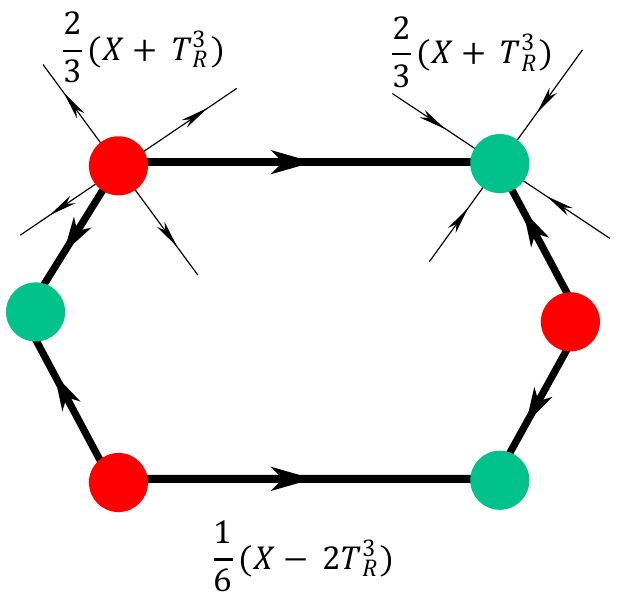
Figure 3 . Necklace with SU(4) c monopoles (red) and antimonopoles (green) from the symmetry breaking SO(10) SU(4) c SU(2) L U(1) R SU(3) c U(1) B − L SU(2) L U(1) R SU(3) c → × × → × × × → × SU(2) L U(1) Y Z 2 , where the last step is achieved by a 126 -plet of SO(10). We assume that the × × monopoles from the first step of symmetry breaking are inflated away. We display explicitly only the Coulomb magnetic flux of one monopole and one antimonopole and the magnetic flux along one of the tubes. This necklace may survive